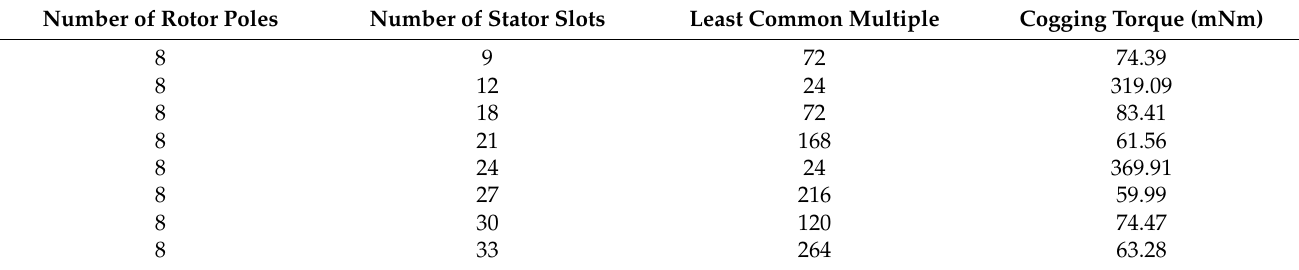
Table 6. The magnitudes of cogging torque under different numbers of stator slots when the number of rotor poles is 8. Number of Rotor Poles Number of Stator